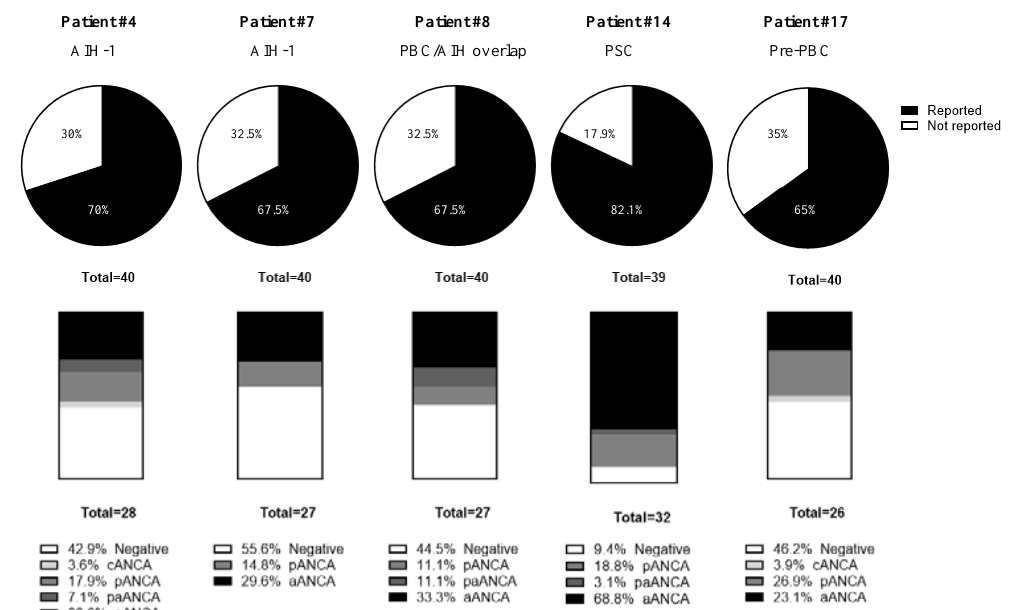
Figure 4. ANCA results in the five ANCA positive patients. Proportion of reported results for ANCA test and proportion of ANCA patterns for the reported results. Abbreviations: aANCA, atypical ANCA; ANCA, anti-neutrophil cytoplasm antibodies; cANCA, cytoplasmic ANCA; paANCA, perinuclear/atypical ANCA; pANCA, perinuclear ANCA; AIH-1, autoimmune hepatitis type 1; PBC, primary biliary cholangitis; PSC, primary sclerosing cholangitis.